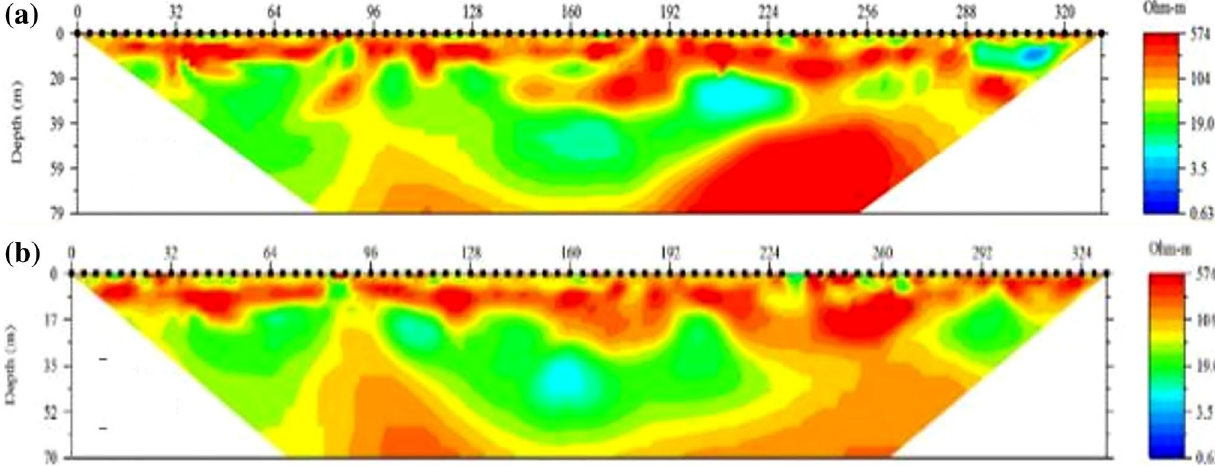
Fig. 6 Resistivity models obtained from the independent inversion of pole-dipole resistivity data measured in May 2014 ( a ) and December